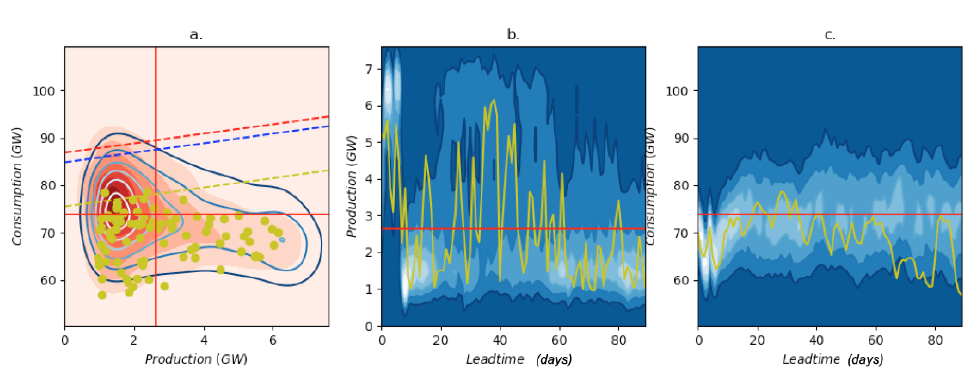
Figure 10. Same as Figure 8 for winter 2014 and the 3-month forecast horizon (January to March).